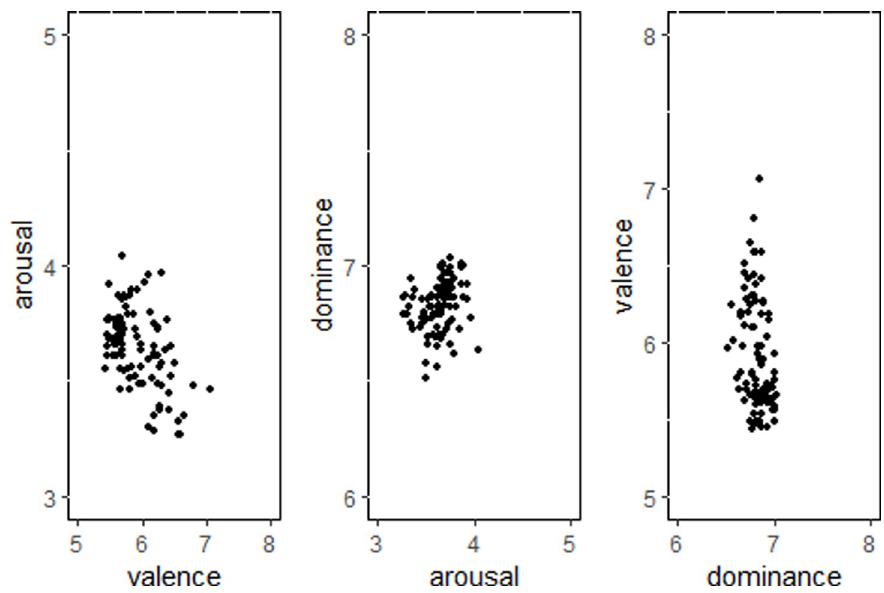
Fig 4. Scatterplot of neutral